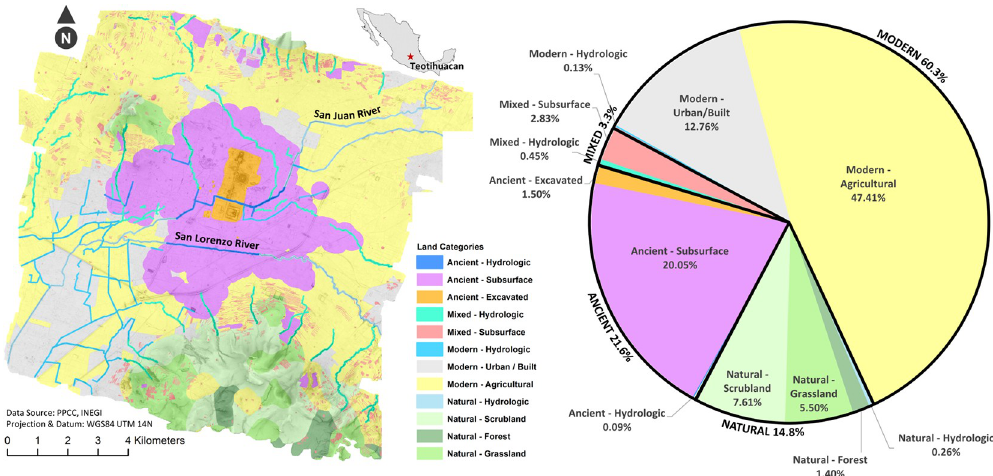
Fig 9. Distribution of natural versus modern, ancient, and mixed artificial ground calculated from the lidar map of the Teotihuacan Valley. Total area represents 165 km 2 . See S1F Table in S1 File for details of surface area.